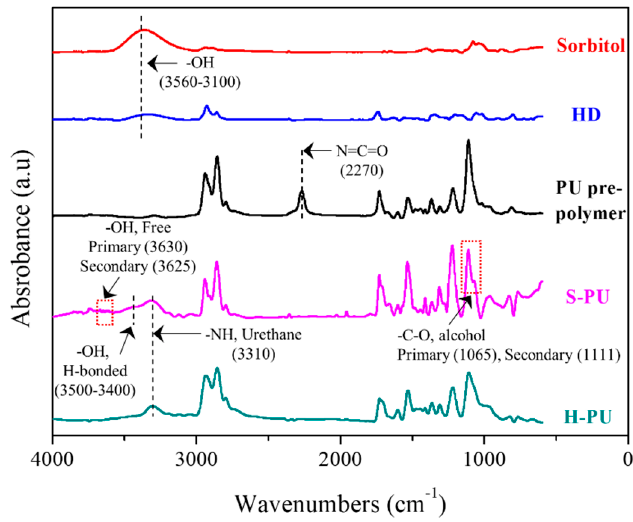
Figure 1. FT-IR spectra of the chain extenders (sorbitol and HD), PU prepolymer, S-PU, and H-PU. Table 1. Composition and molecular weights of the prepared PUs.